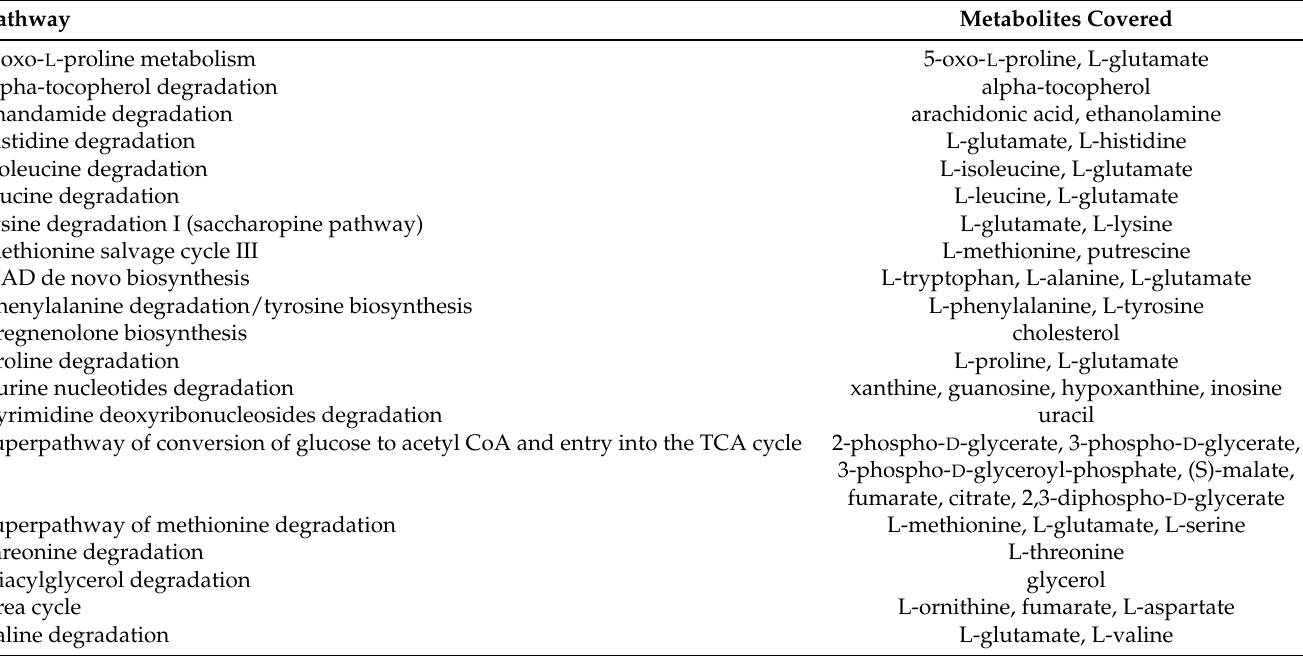
Table A1. ST000061, Representative Pathway Covering Using Constant Cost